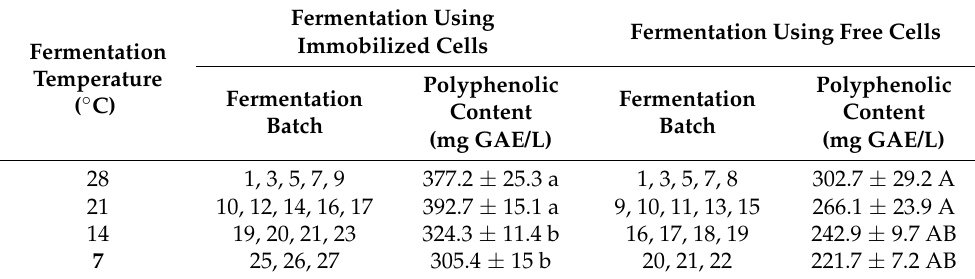
Table 7. Polyphenolic content of wines produced from must (12.5 ◦ Be) using immobilized and free cells at 28, 21, 14 and 7 ◦ C.